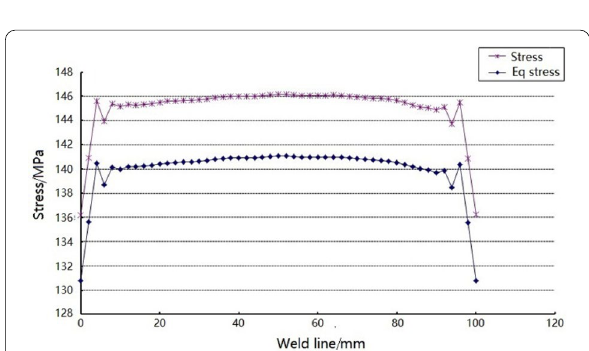
Figure 20 Calculated stress of lap joint structure of 6005 aluminum alloy